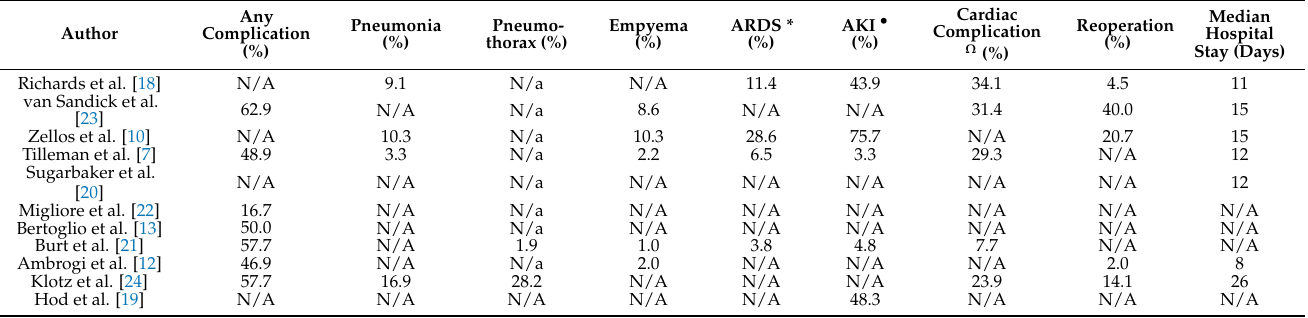
Table 3. Complications reported in